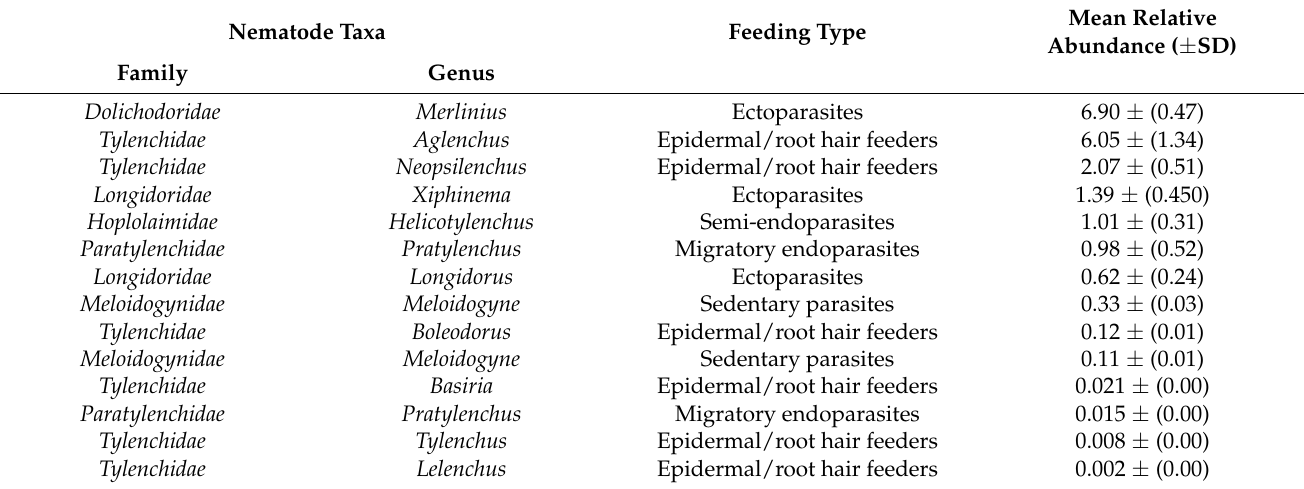
Table 1. The mean relative abundance of PPN taxa found in the control group (n = 5) of site 1, including their standard deviations in